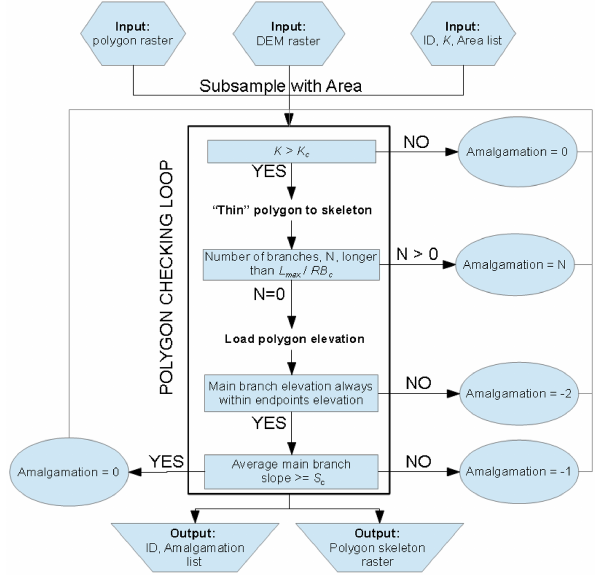
Figure 4. Flowchart of the algorithm for automatic detection of amalgamation. The algorithm is provided in the Supplement. Inputs are used to individually analyse polygons based on geometric and topographic characteristics, following a series of conditional tests that lead to a polygon score. A score of zero means that the polygon is considered clean and any other scores refer to some sort of amal- gamation. K is the equivalent ellipse aspect ratio (see Eq. 3), L max is the length of the longest branch of a polygon, RB c is an arbitrary critical length ratio and S c is a critical slope